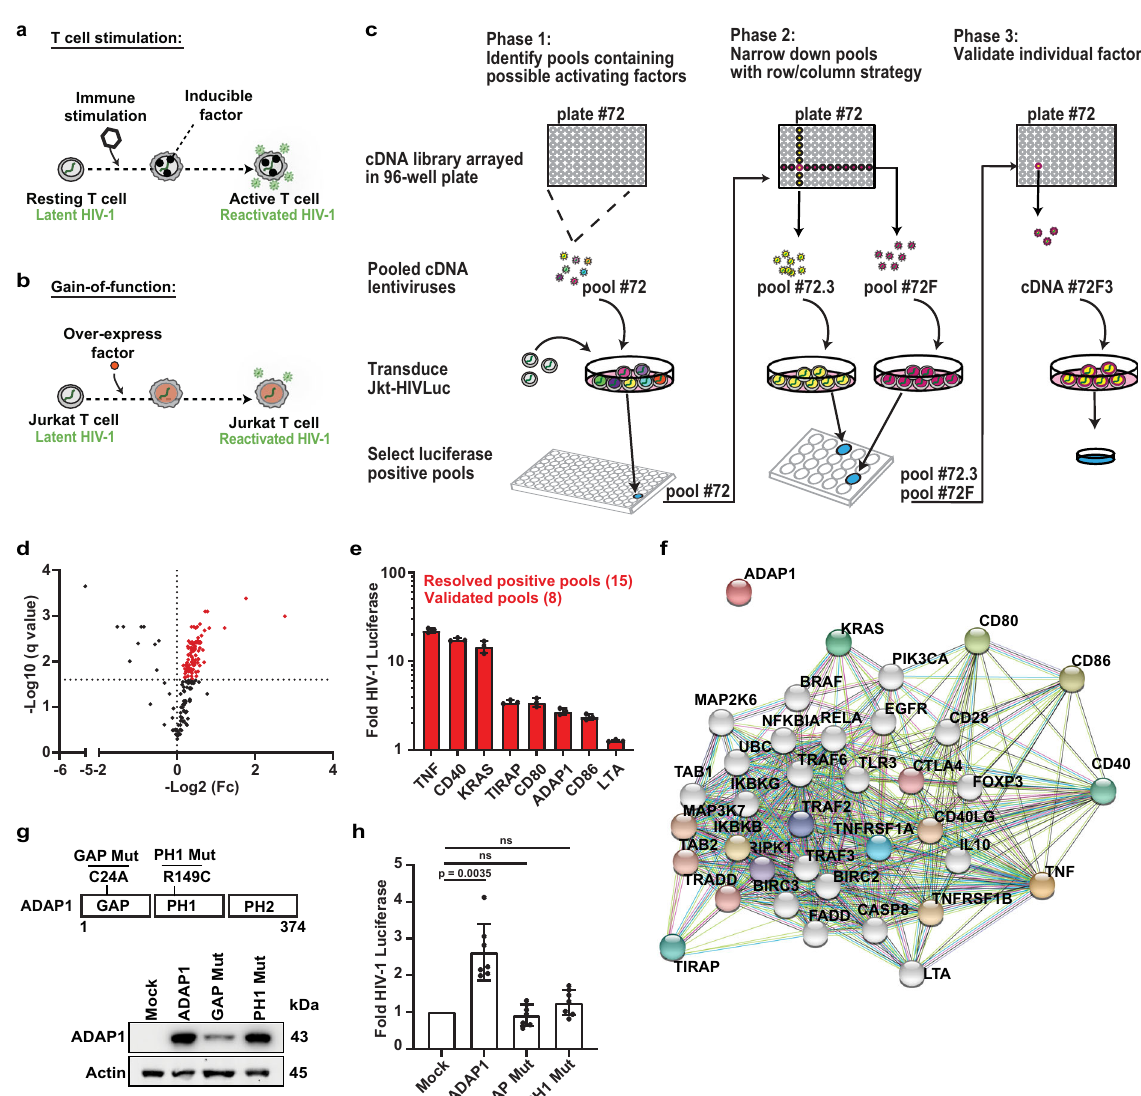
Fig. 1 Gain-of-function screen reveals ADAP1 as a latent HIV-1 activating factor with undescribed T cell signaling functions. a Schematic of immune stimulation-mediated CD4 + T cell gene expression coupled to HIV-1 gene expression motivating the screen in b . b Gain-of-function screen approach to discover undescribed T cell signaling-transcriptional regulators relevant for latent HIV-1 reactivation and T cell programs. c Schematic of 3-phase screen approach. Pool 72 is highlighted as example. See “ Methods ” for screen details. d Volcano plot summarizing results of phase 1 of gain-of-function screen (repeat 1). Each dot is a pool sample (representing 96 cDNAs/pool) mean luciferase activity ( n = 3) and statistical signi fi cance was determined using a multiple unpaired t -test. Dots in red denote positive pools above the chosen cutoff of Log 2 Fc > 0 with an FDR < 2.5% and cross-referenced with the results of screen repeat 2 (Supplementary Fig. 1c) to determine which pools to resolve (see Supplementary Fig. 1d details). e Summary of candidate HIV-1 activating factors fi rst identi fi ed in the gain-of-function screen and then validated individually. Data represents mean ± s.d. of three independent experiments ( n = 3). f Candidates from e were entered into STRING (Search Tool for the Retrieval of Interacting Genes/Proteins), a search database that identi fi es known and predicted protein – protein functional and direct associations and mined for predicted functional interactions based on available databases (represented by different colored edges). Colored nodes are inputted list from e and fi rst shell of predicted interactors, while white nodes are secondary interactors. Figure displayed contains 30 additional nodes with the inputted 7 nodes. g Domain mapping analysis. Top: schematic of ADAP1 domains and point mutations used for further analysis. Bottom: western blot of Jkt-HIVLuc cells transduced with lentiviruses expressing empty vector (Mock), wild-type (WT) ADAP1, or point mutants (GAP Mut, PH1 Mut), and probed with the indicated antibodies. h Fold luciferase activity of Jkt-HIVLuc cells transduced in g . Data represents mean ± s.d. of seven independent experiments ( n = 3) (one-way ANOVA followed by Dunnett ’ s test for multiple comparisons to mock). ns not signi fi cant. Source data are provided as a Source Data fi